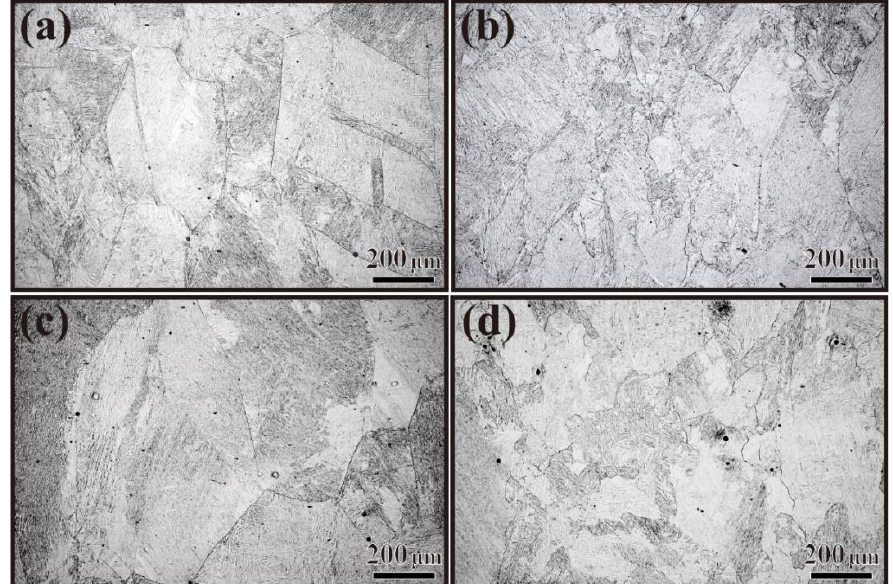
Figure 3. Optical metallographs etched in picric acid solution: ( a ) Steel 2N treated at 900 ◦ C for 10 s; ( b ) Steel 2N treated at 900 ◦ C for 1000 s; ( c ) Steel 3N treated at 900 ◦ C for 10 s; ( d ) Steel 3N treated at 900 ◦ C for 1000